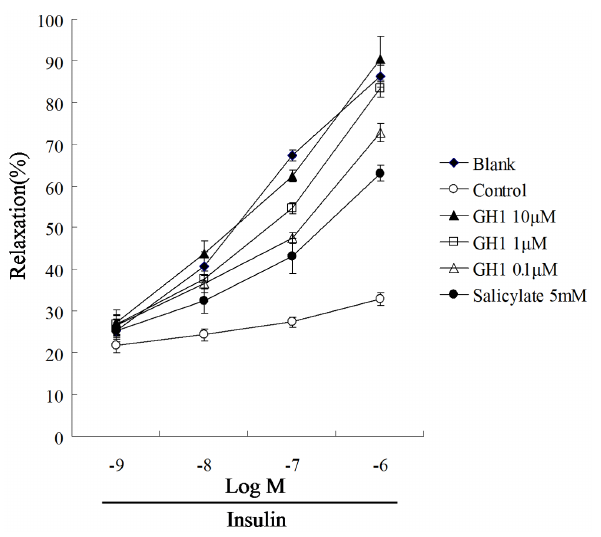
Figure 8. Tectorigenin restored PA-induced loss of endotheli- um-dependent vessel relaxation in the rat aorta. The aortic ring was pretreated with tectorigenin or salicylate for 30 min, then stimulated with PA (100 m M) for 30 min. After washing out of tectorigenin and PA, the aortic ring was pre-contracted with phenylephrine (10 2 6 M), and then the relaxation was induced by insulin treatment. Salicylate was used as a positive control. The blank was treated with an equal amount of the vehicle (medium containing 0.1% DMSO and 10% BSA). The results were expressed as the mean 6 SD ( n =4).